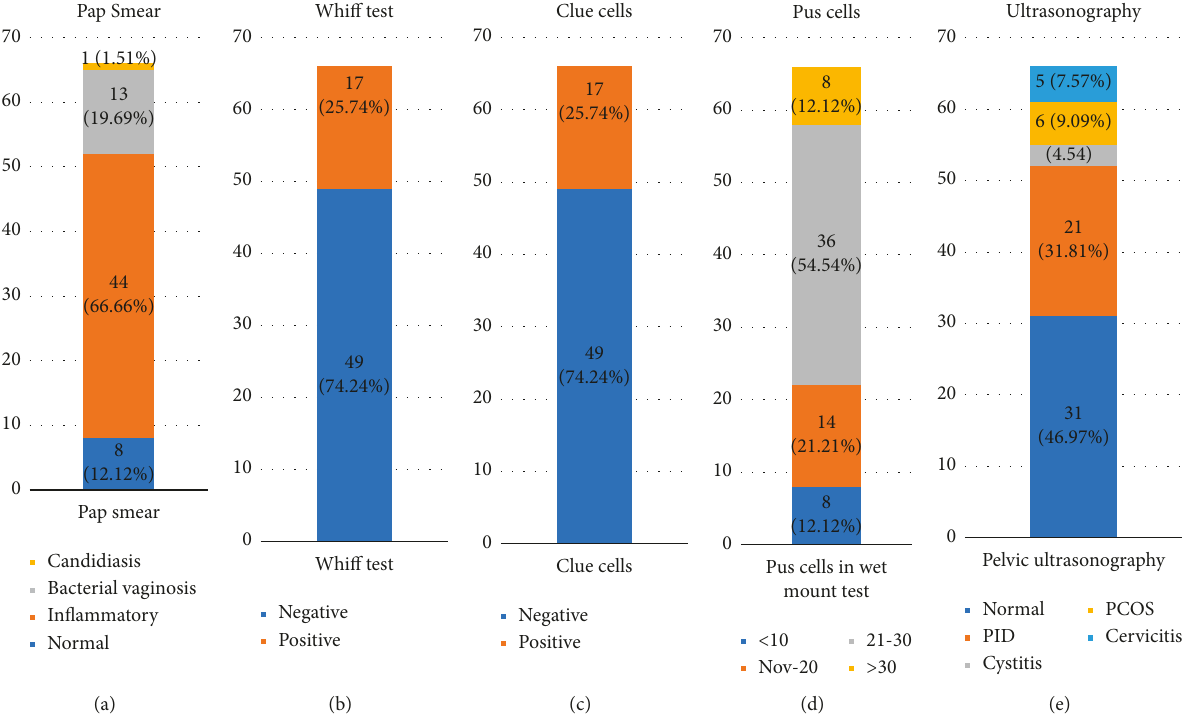
Figure 6: Specific investigations of participants with abnormal vaginal discharge. (a) Pap smear. (b) Whiff test. (c) Clue cells. (d) Pus cells. (e)